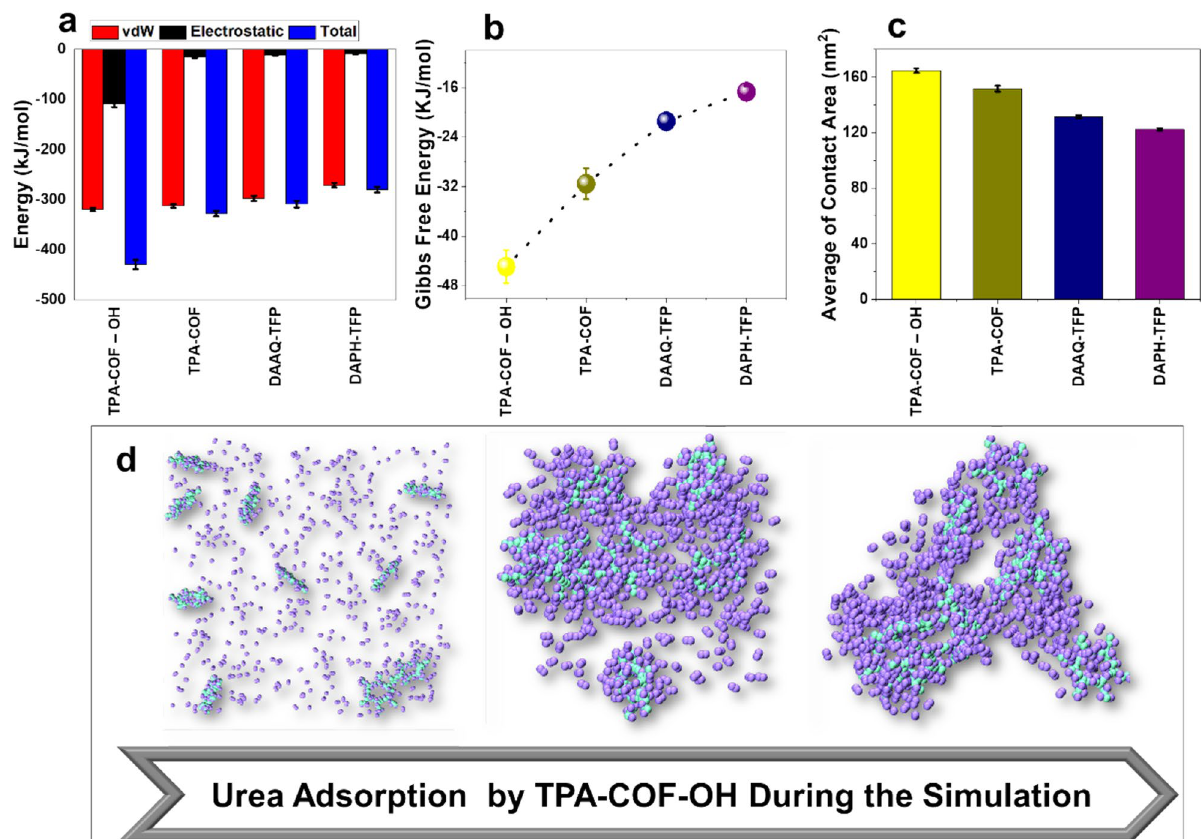
Figure 4. Coarse-grained simulation results. ( a ) Interaction energy ( b ) Gibbs free energy ( c ) Average of contact area ( d ) Process of urea adsorption by TPA-COF-OH during the